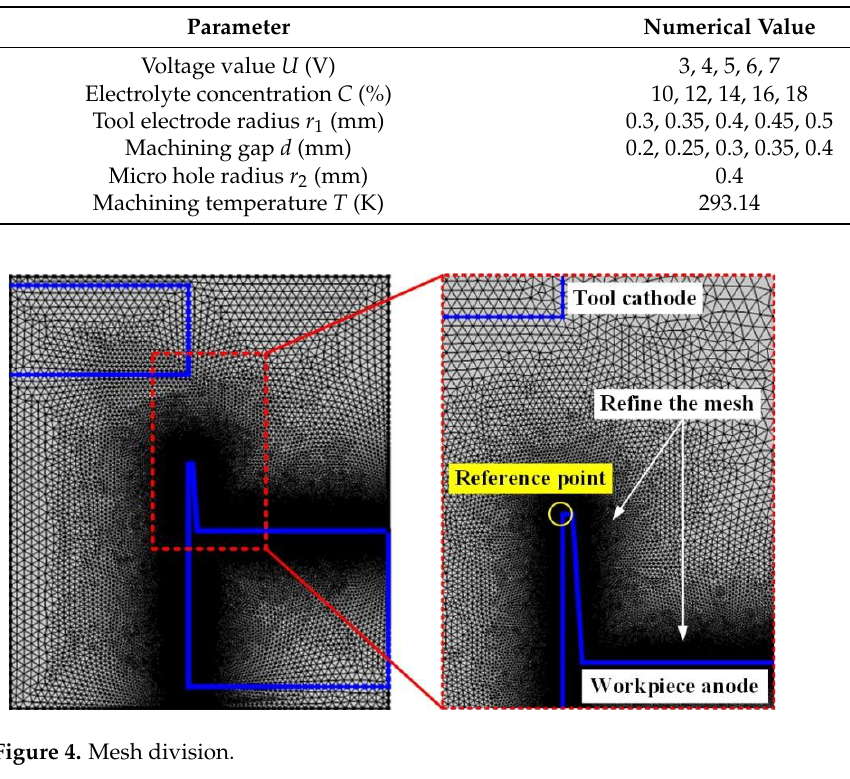
Table 1. Simulation parameters.